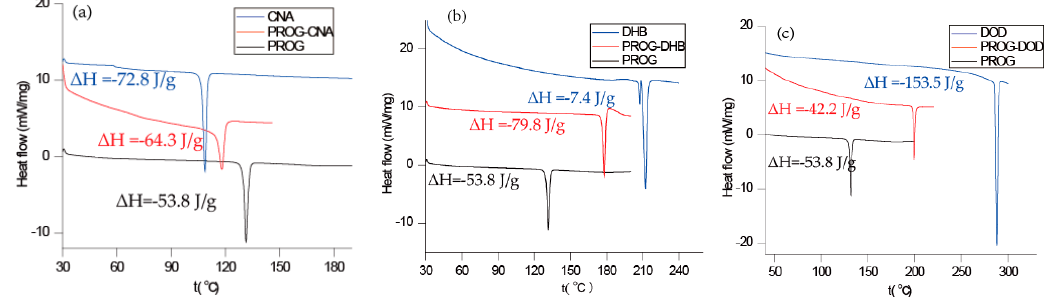
Figure 7. Combined DSC plots of PROG, the CCFs and the co-crystals: ( a ) CNA, PROG-CNA, and PROG; ( b ) DHB, PROG-DHB, and PROG; and ( c ) DOD, PROG-DOD, and PROG.